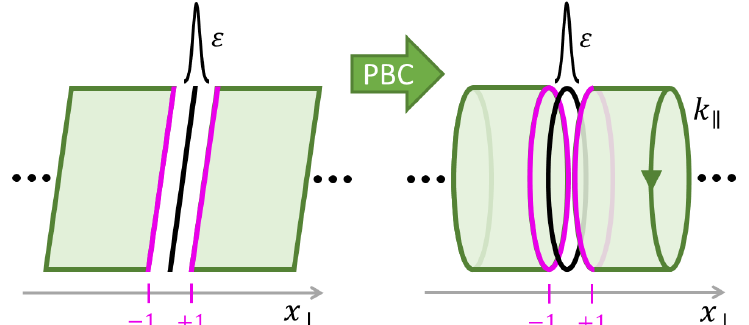
Figure 1: Cylindrical geometry obtained by applying periodic boundary conditions (PBC) along the direction parallel to the boundary in a 2D plane, where x ⊥ denotes a coordinate in the perpendicular direction measured in units of the lattice constant. In this geometry there is a well defined momentum k (cid:107) and the open boundaries at x ⊥ = ± 1 (magenta lines) are obtained by adding a localized impurity line with an amplitude (cid:34) → ∞ (black line) at x ⊥ = 0. The impurity line breaks the translational symmetry in the x ⊥ − direction and opens two boundaries in the bulk infinite